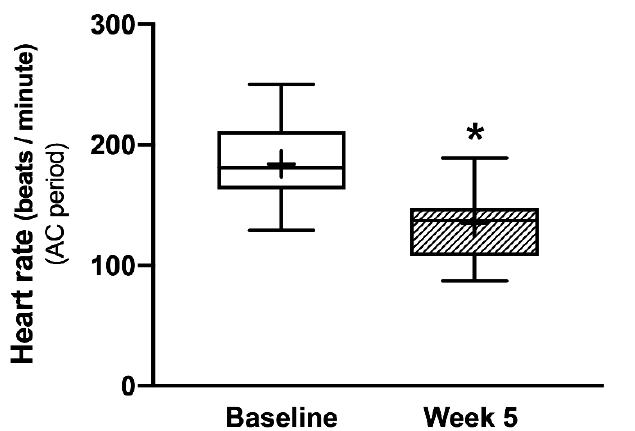
Figure 3. A box plot of heart rate ( HR ) during 6MWT in TC dogs. * p < 0 . 05 comparison with the